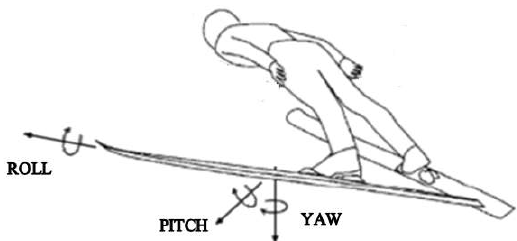
Figure 2. Representation of the roll, pitch and yaw ski movements (adapted from